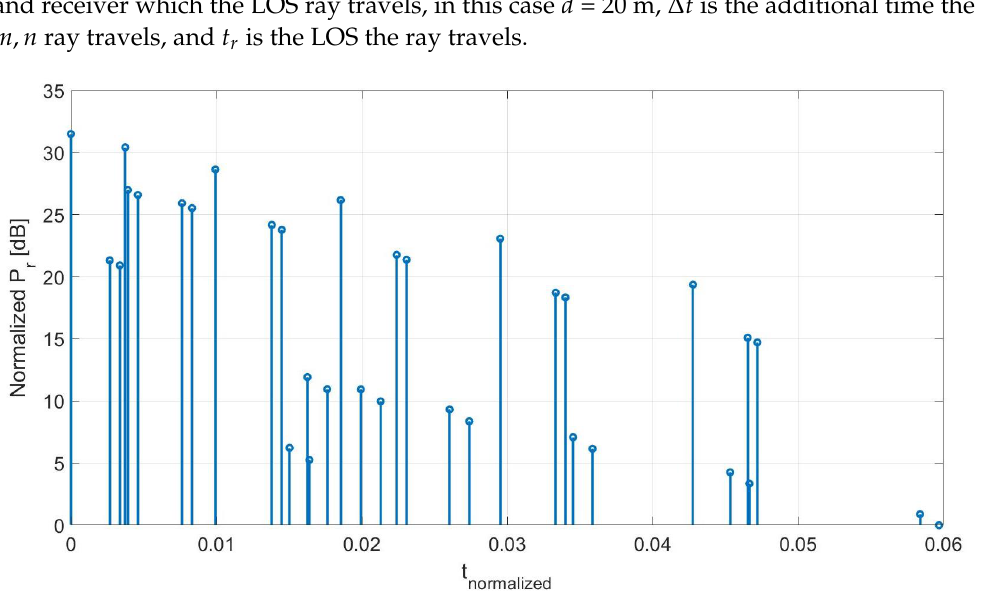
Figure 1. Reflected rays not arriving simultaneously at the receiver.